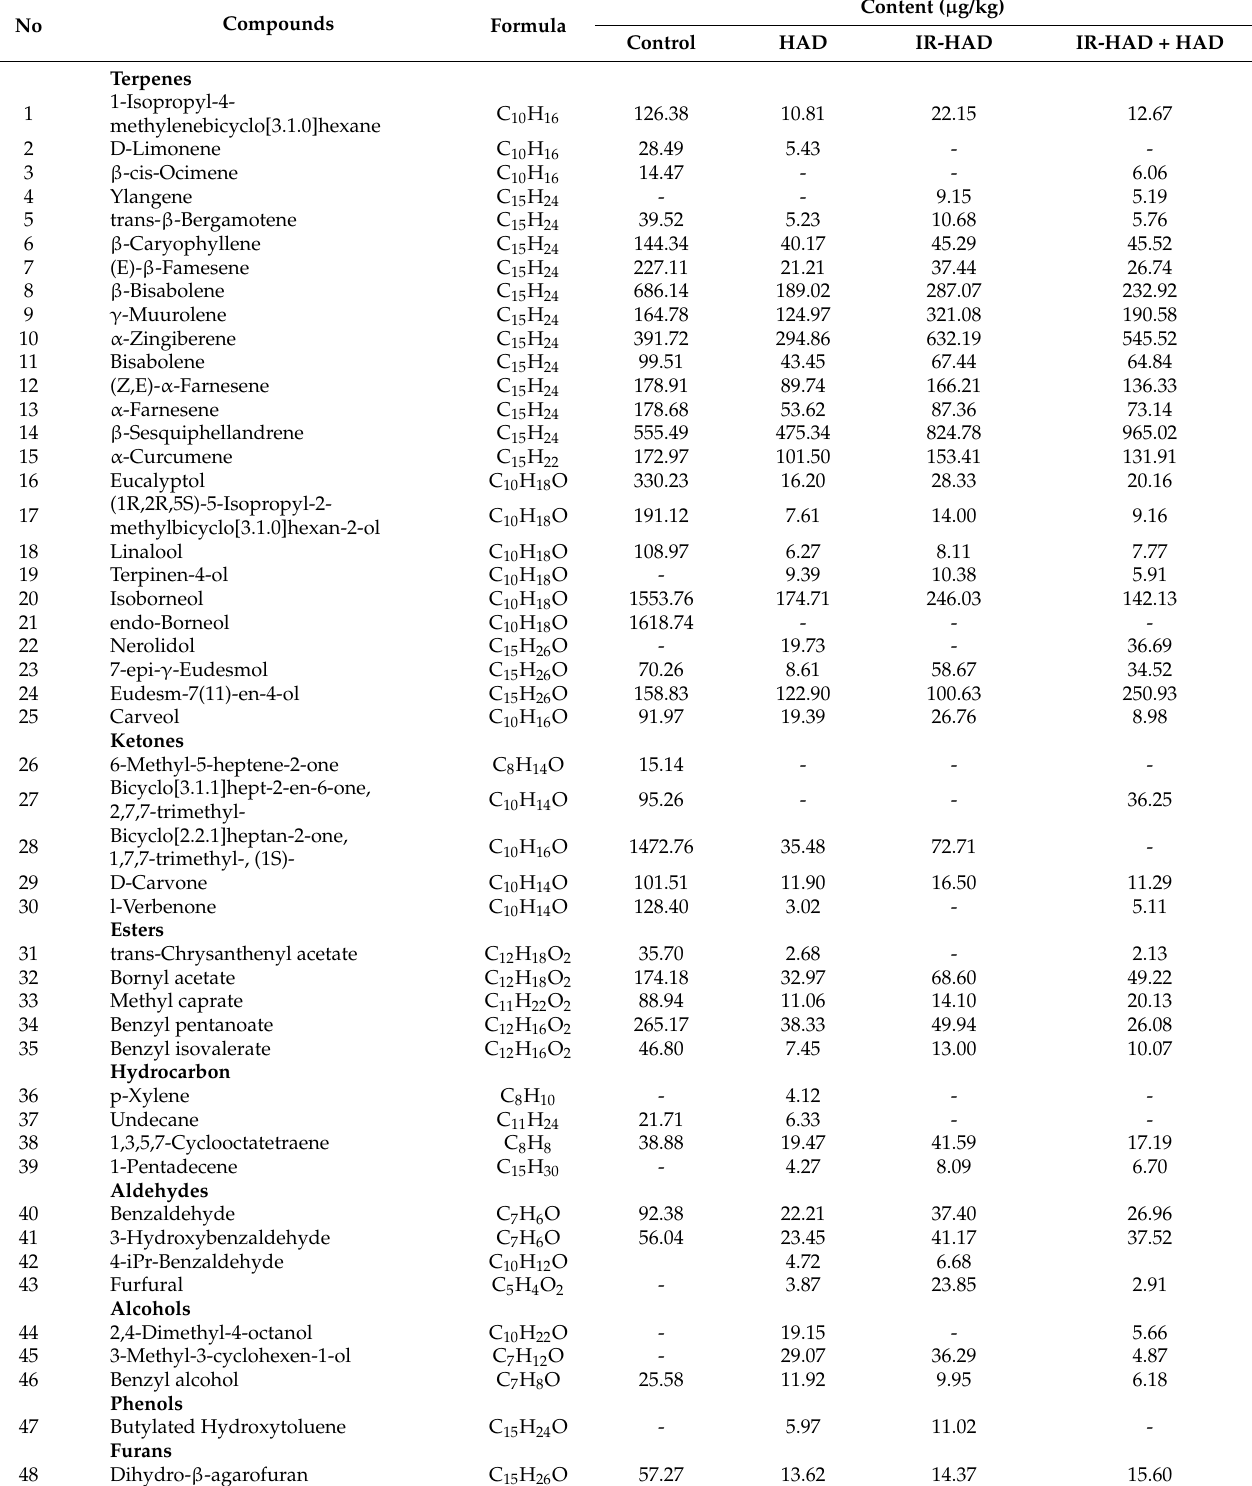
Table 3. Effects of drying methods on volatile compounds of chrysanthemum